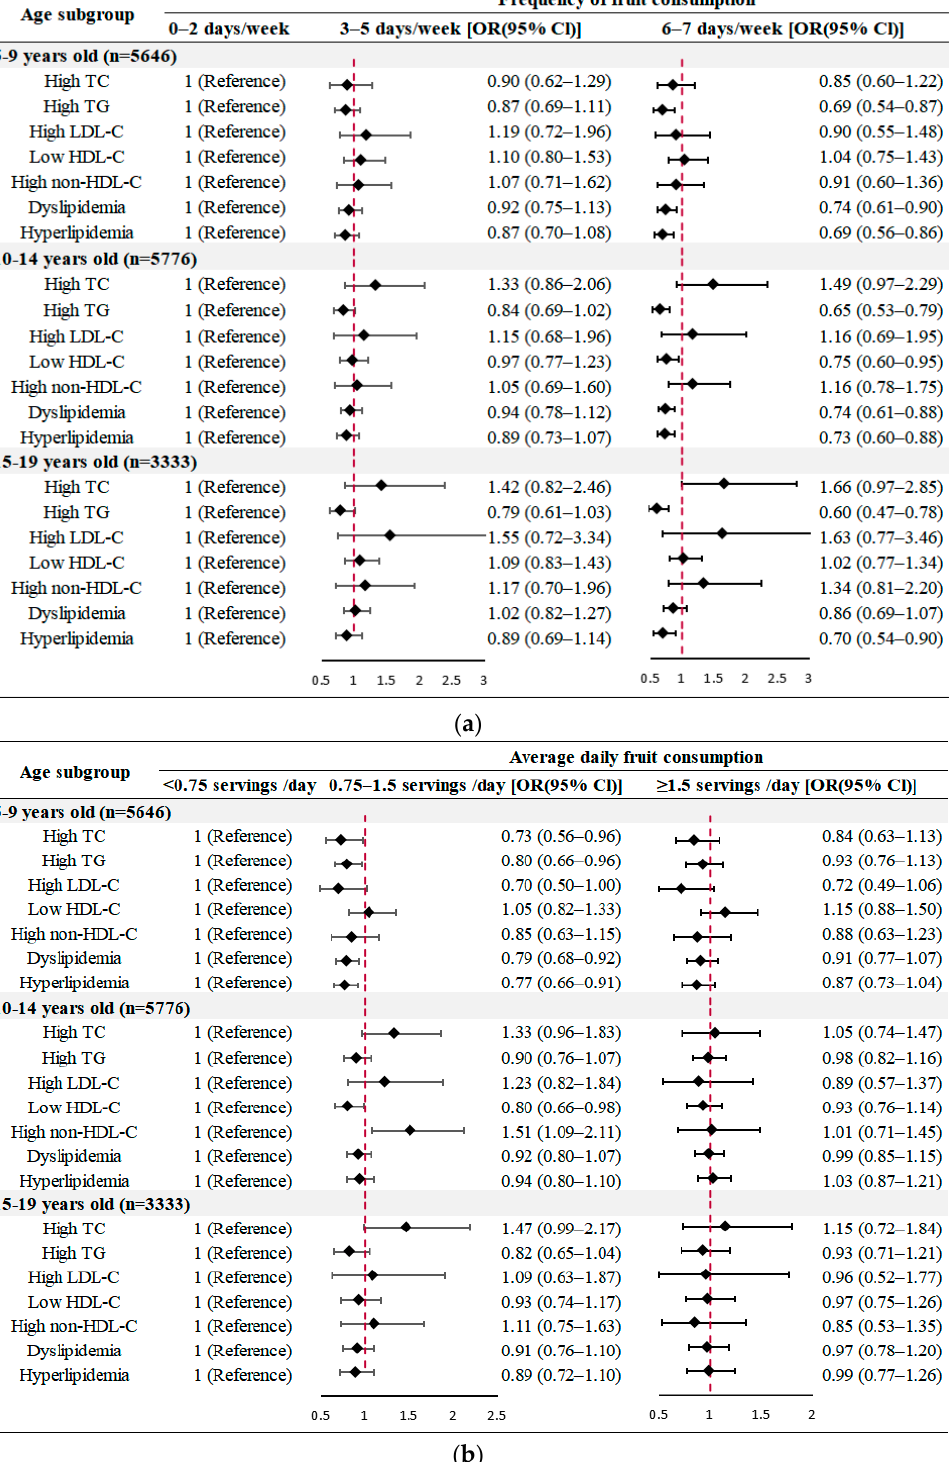
Figure 2. Age-specific analysis of the associations between fruit consumption and lipid profile (adjusted for sex, BMI values, residence area, ethnicity, incomes, parental educational attainment, parental weight, vegetable consumption, sugar-sweetened beverages consumption, meat consump- tion and physical activity) ( a ) Frequency of fruit consumption; ( b ) Average daily fruit consumption. TC, total cholesterol; TG, triglycerides; LDL-C, low density lipoprotein-cholesterol; HDL-C, high density lipoprotein-cholesterol; diamond symbol, point estimates; red dashed lines, invalid